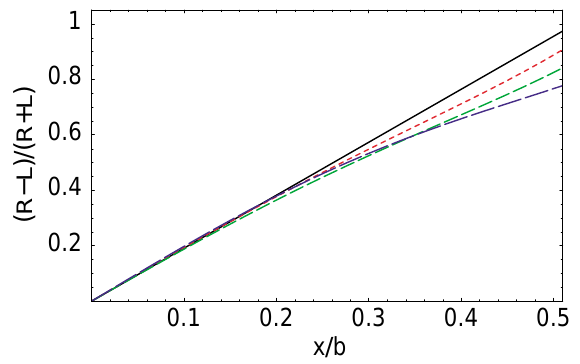
FIG. 3. (Color) Same as Fig. 2, but with s x (cid:2) b (cid:1) 0.2 , s y (cid:1) 0 .